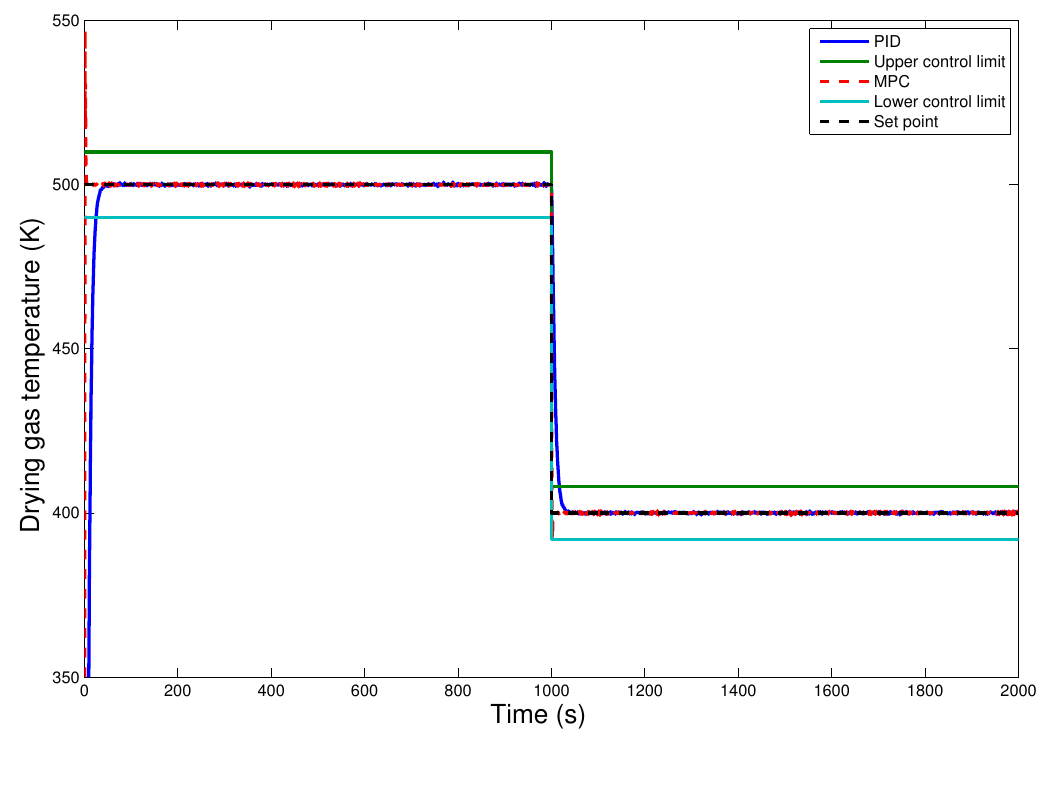
Controller performance evaluation for the set point tracking of the drying gas